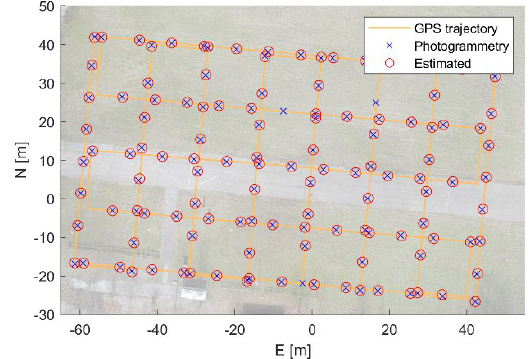
Figure 8. Comparison between the APC position interpolated from the GNSS trajectory (red circle) and the photogrammetric plotted after the synchronization. 𝒘𝒘 𝑪𝑪𝑪𝑪𝑪𝑪 − 𝑳𝑳